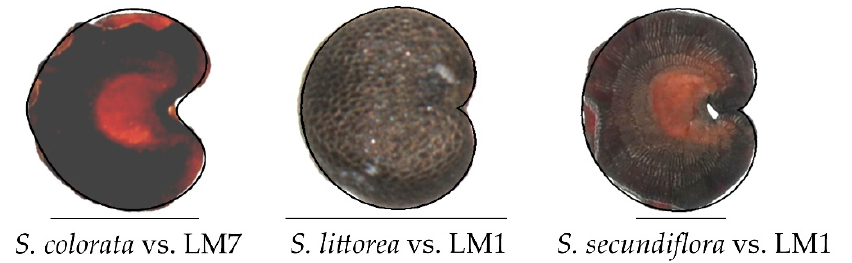
Figure 8. Representative images of the group of smooth seeds. The mean values of J index obtained with the models shown are 90.2 ( S. colorata with LM7); 91.4 ( S. littorea with LM1) and 91.1 ( S. secundiflora with LM1).